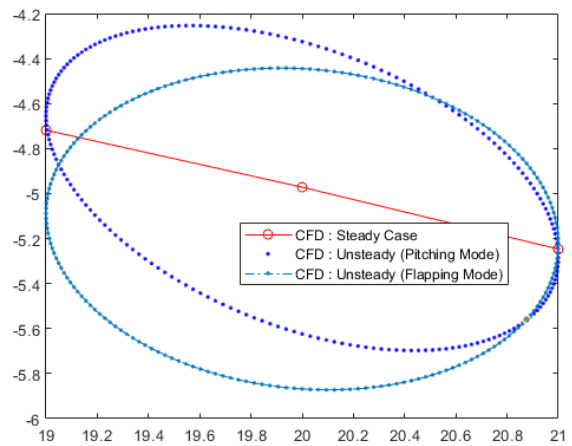
Figure 15. Comparison between Steady case Cm plot and Unsteady Cm history hysteresis.